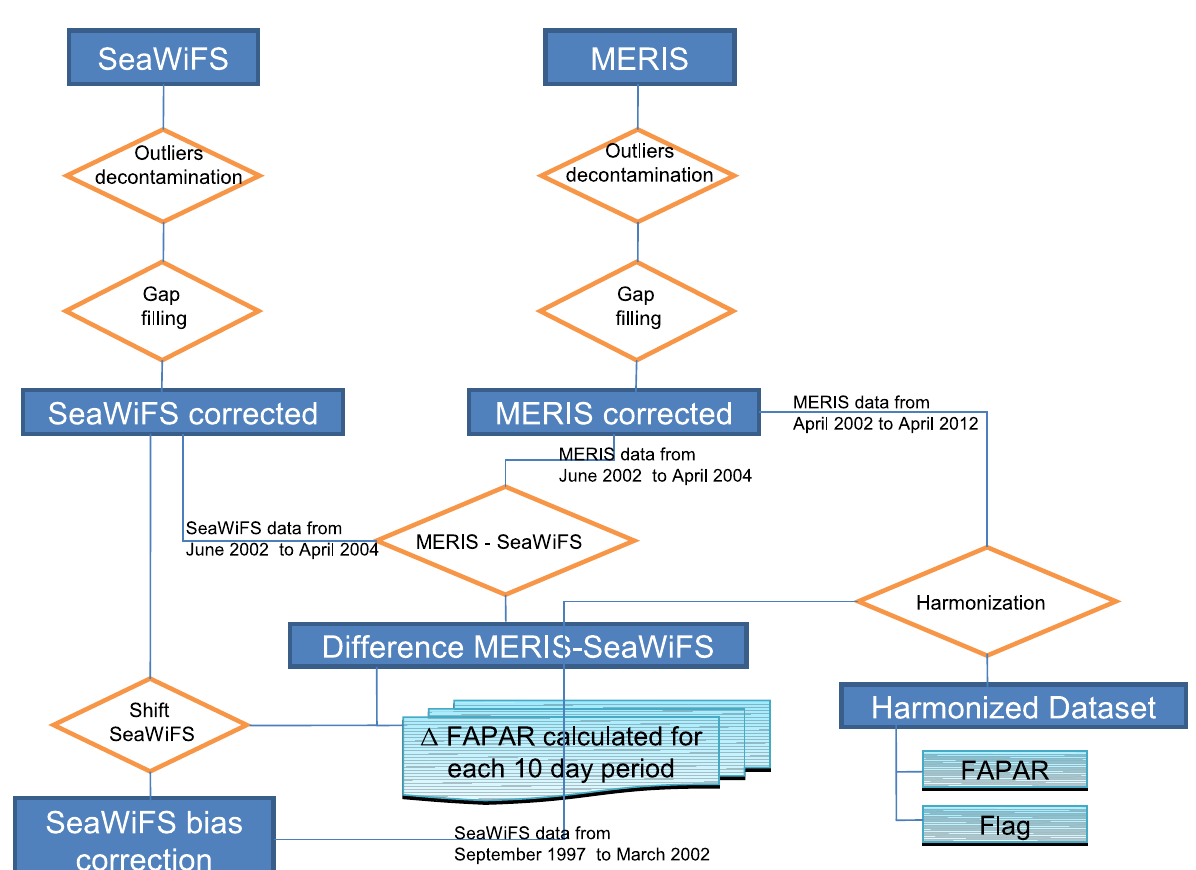
Figure 3. Flow chart of the harmonization